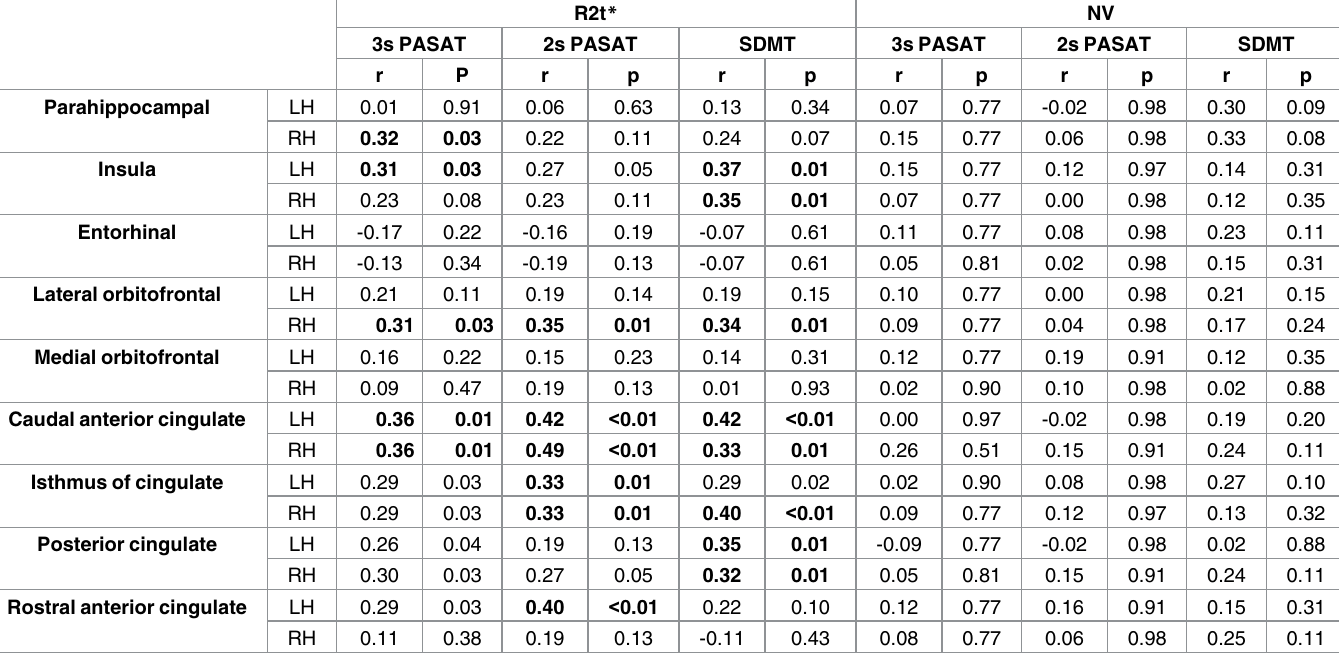
Table 2. Correlations between clinical cognitive tests and R2t * and NV in limbic